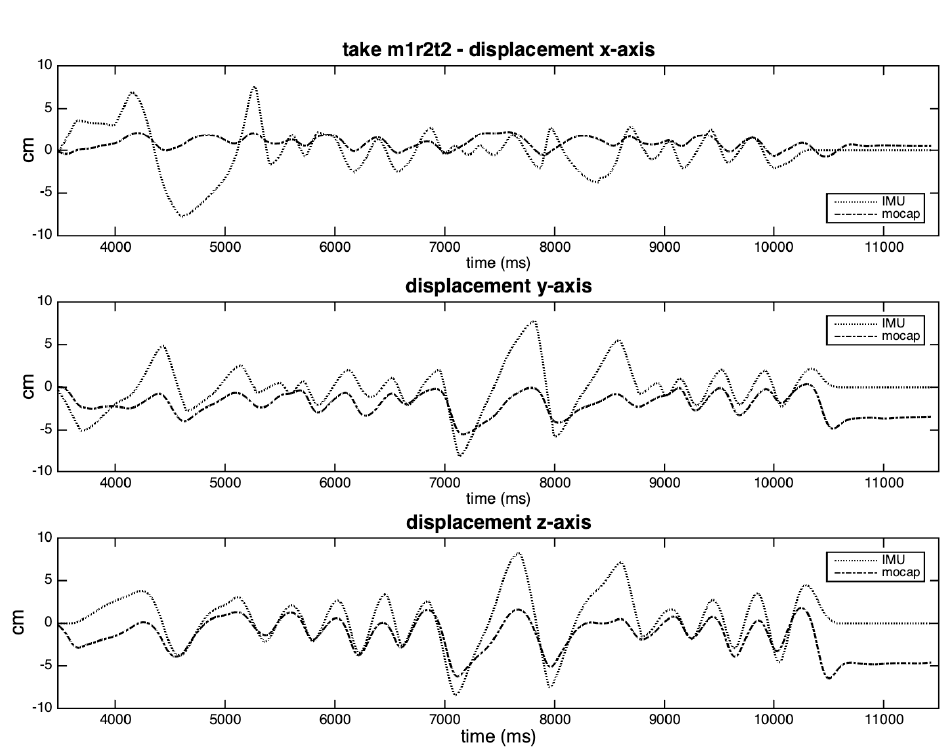
Figure 17. Displacement curves estimated for each axis of take m1r2t2 , balanced according to the stronger